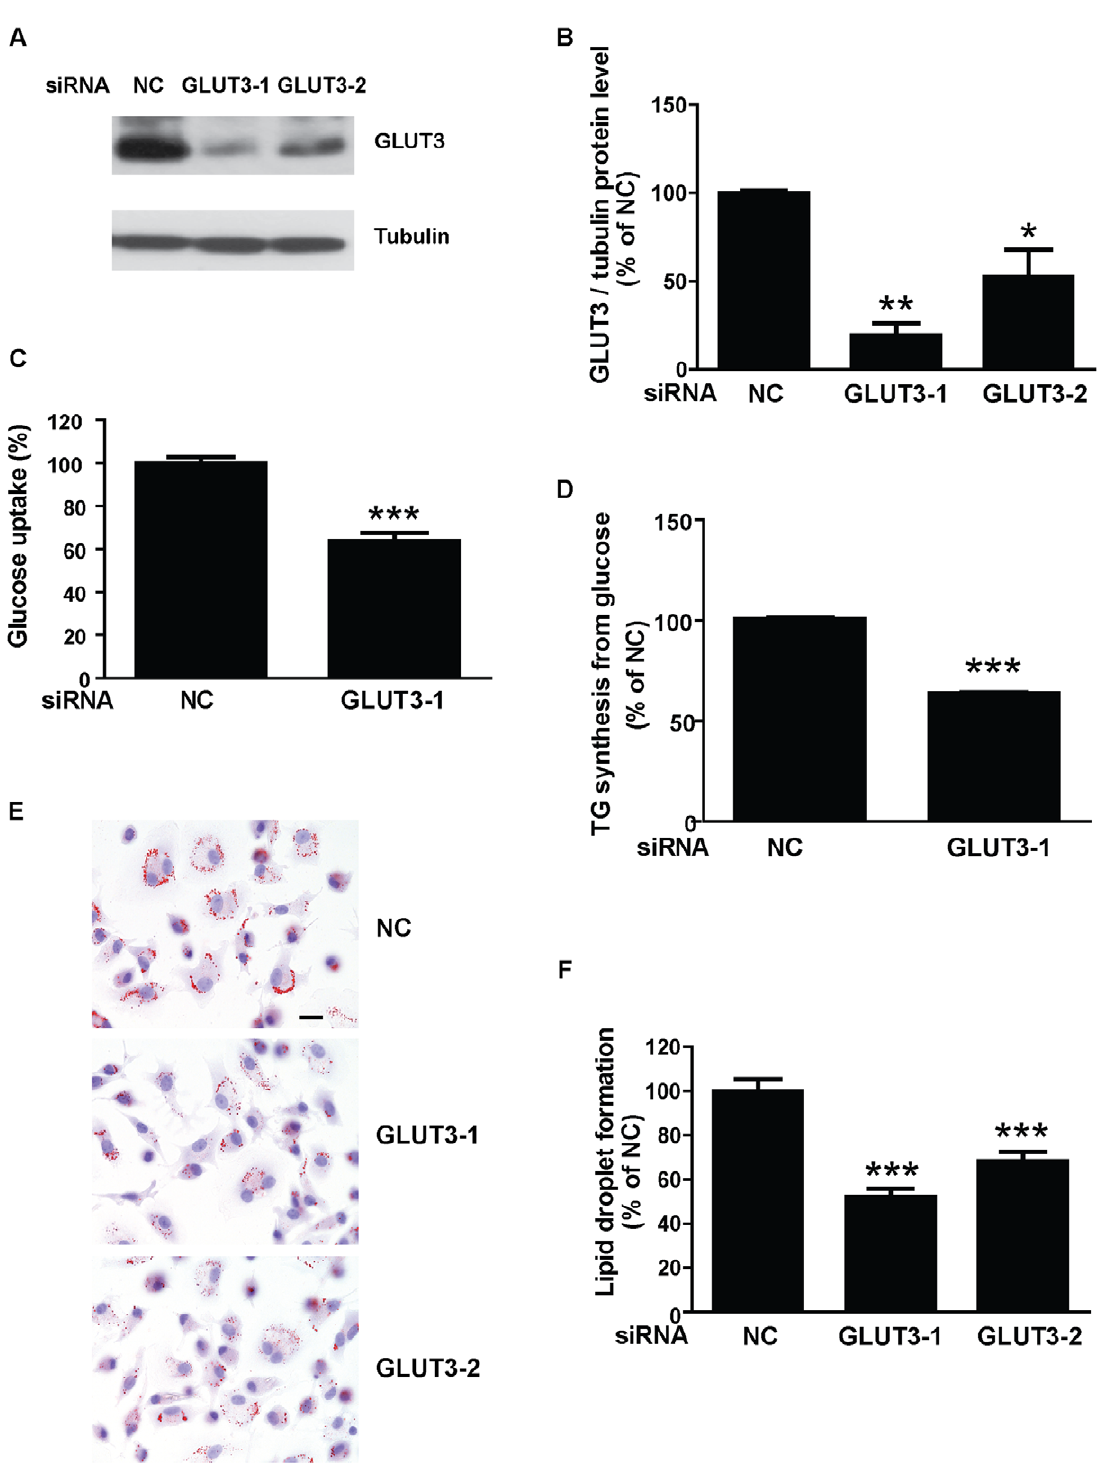
Figure 3. GLUT3 knockdown reduces glucose uptake and lipid droplet formation in hypoxic human macrophages. Human monocyte- derived macrophages were transfected with control siRNA or siRNA against GLUT3 and cultured in medium containing 11 mmol/l glucose for 24 h in hypoxia (1% O 2 ). ( A ) Representative immunoblots of GLUT3 and tubulin in hypoxic human macrophages transfected with negative control (NC) or GLUT3 siRNA. ( B ) Quantification of ( A ). Data are mean 6 SEM from 4 macrophage donors. ( C ) Knockdown of GLUT3 reduces glucose uptake in hypoxic human macrophages. Data are mean 6 SEM from 6 macrophage donors. ( D ) Knockdown of GLUT3 reduces triglyceride biosynthesis from radiolabeled glucose in hypoxic human macrophages. Data are mean 6 SEM from 3 macrophage donors. ( E ) Micrograph of Oil Red O-stained hypoxic macrophages transfected with control siRNA or GLUT3 siRNA. Scale bar 10 m m. ( F ) Quantification of ( E ). Data are mean 6 SEM of all cells present in 20 randomly selected pictures from each of 4 macrophage donors. * P , 0.05; ** P , 0.01; *** P , 0.001 vs negative siRNA control.